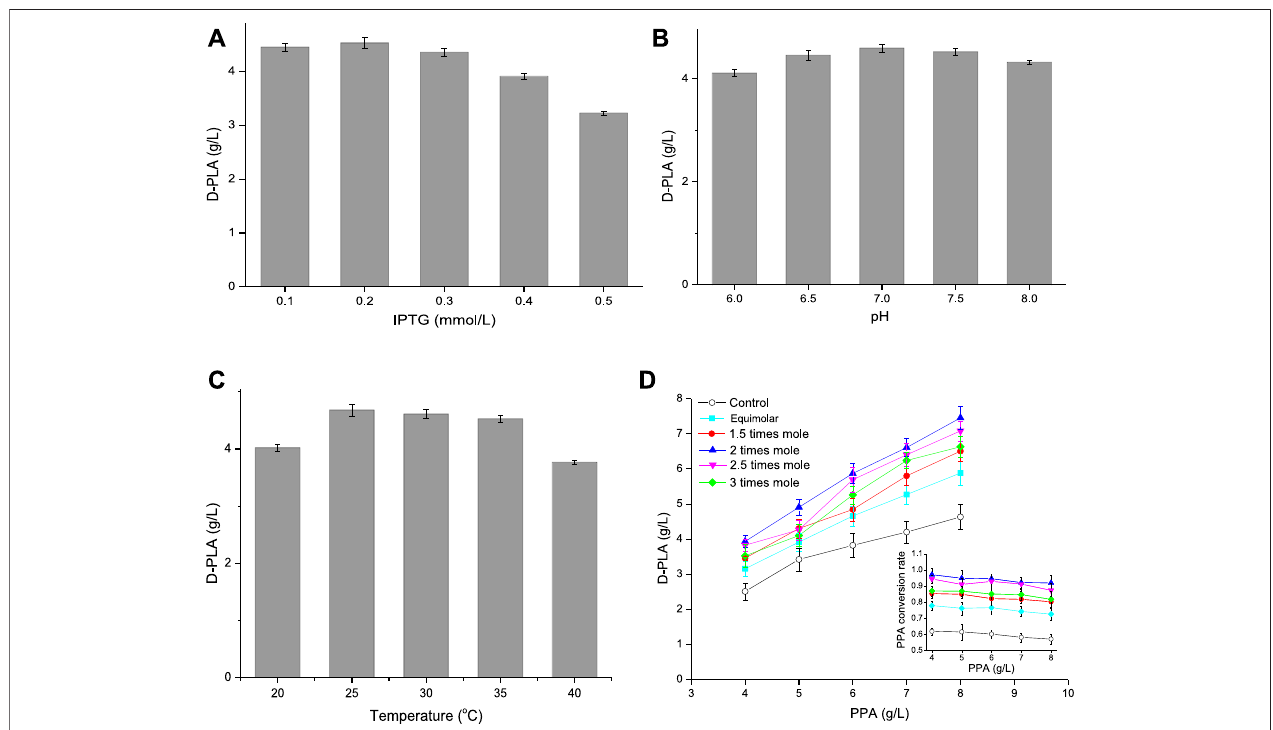
FIGURE5|(A) EffectofIPTGconcentrationonD-PLAtiter; (B) EffectofpHonD-PLAtiter; (C) EffectoftemperatureonD-PLAtiter; (D) Effectofsubstrate(glycerol, relative to PPA) on D-PLA titer. Data are means ± SD ( n (cid:1)